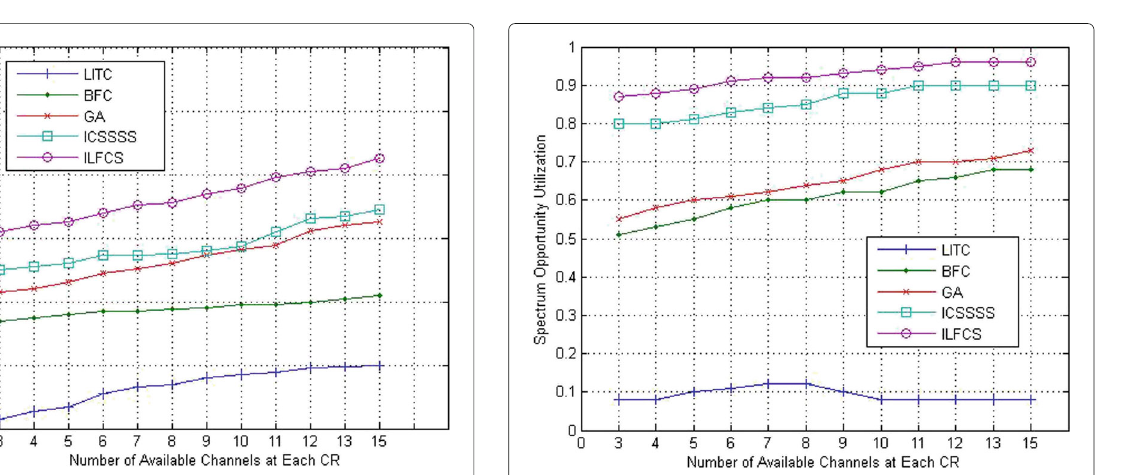
Fig. 13 Average throughput under different number of available channels. The results of different simulation experiments to measure average throughput at different numbers of available channels for the BFC, LITC, GA, ICSSSS, and the ILFCS are shown